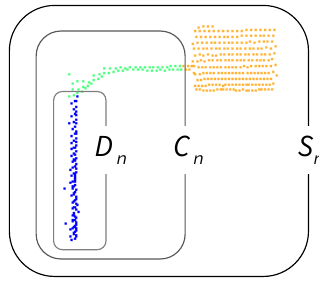
Figure 6. Example of the point clouds of a street sign (orange: points on the planar object, green: points on the pole-like object, blue: points whose neighbors are distributed vertically)